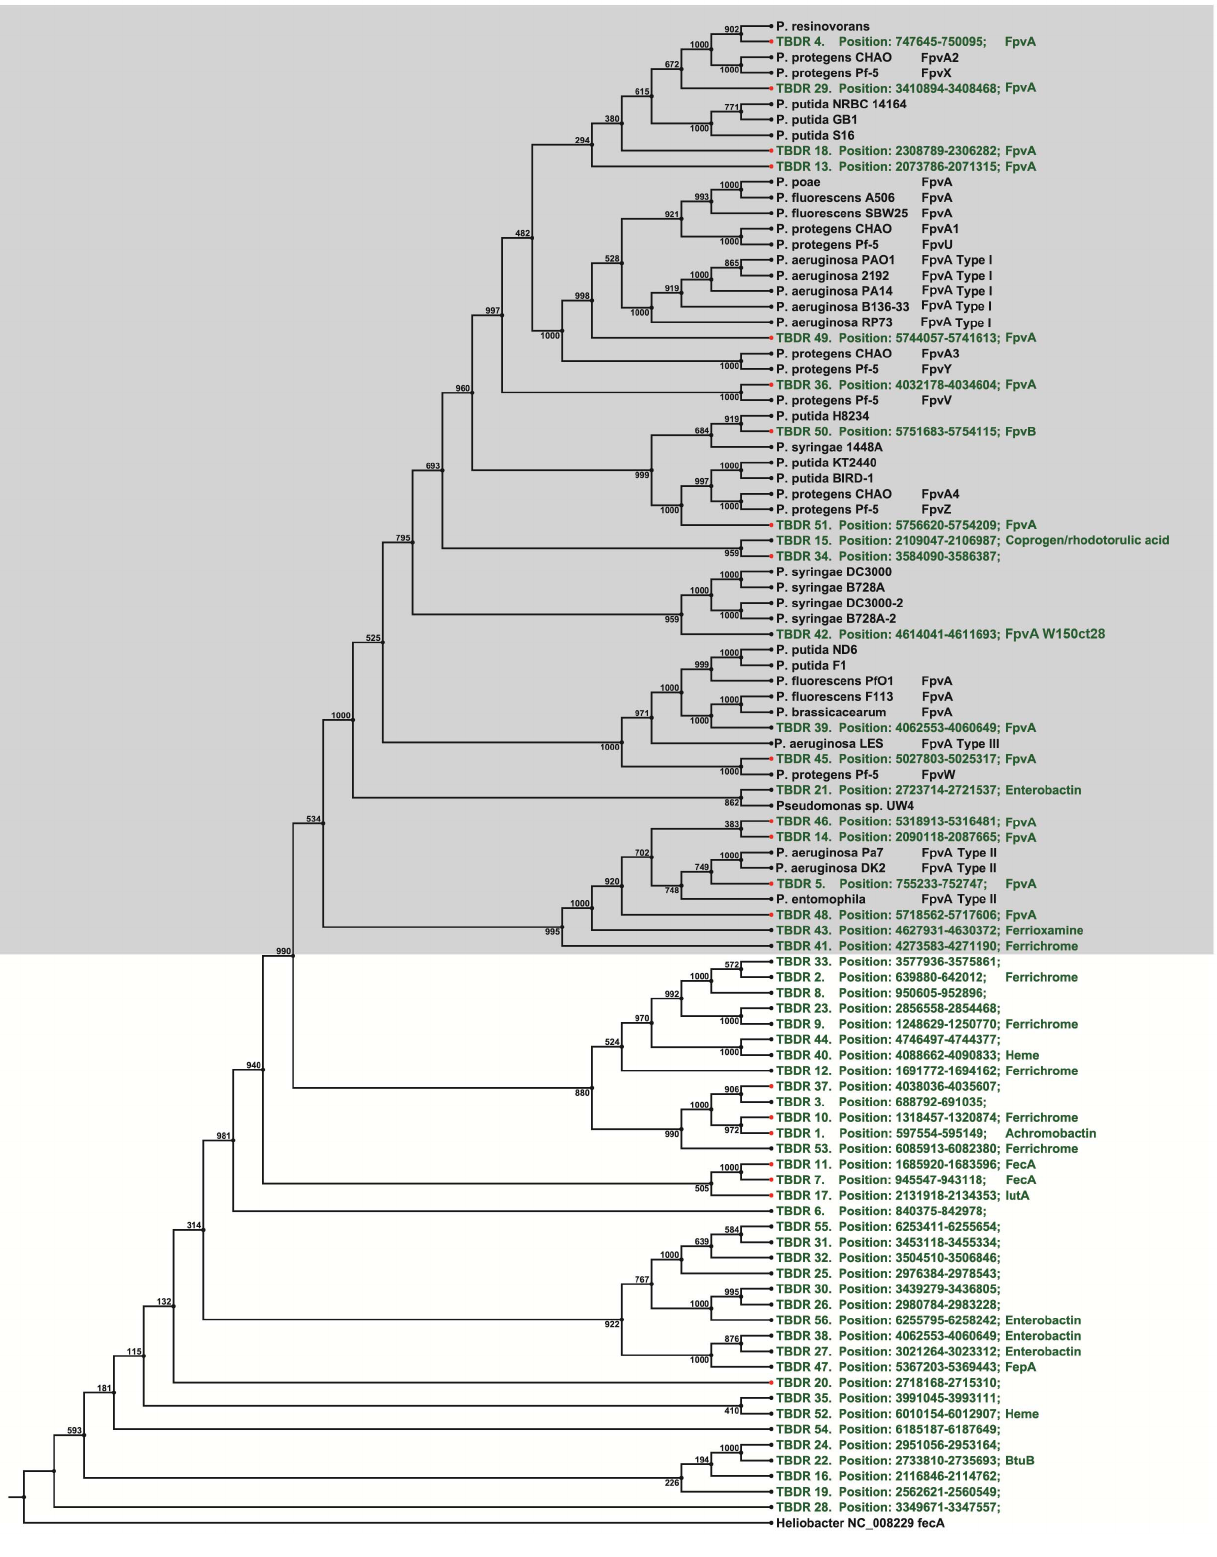
Figure 2. Phylogeny of TonB-dependent receptors. Neighbor joining tree based on the alignment of amino acid sequences of the 56 TonB dependent receptors (TBDR) detected in the genome of W15oct28 (green font) and a selection of known ferric-pyoverdine receptors from different sequenced Pseudomonas genomes (black font). W15oct28 TBDRs that are regulated through sigma-anti-sigma factors are indicated with a red node. Grey surface indicates part of the tree that contains all ferric-pyoverdine receptors that form a separate cluster.